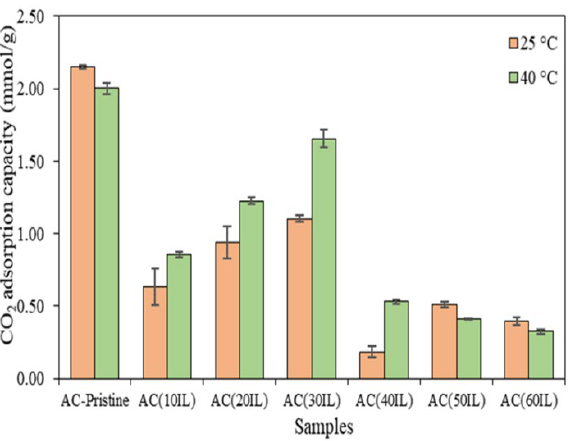
Figure 12. Effect of adsorption temeprature on the CO 2 adsorption capacity.